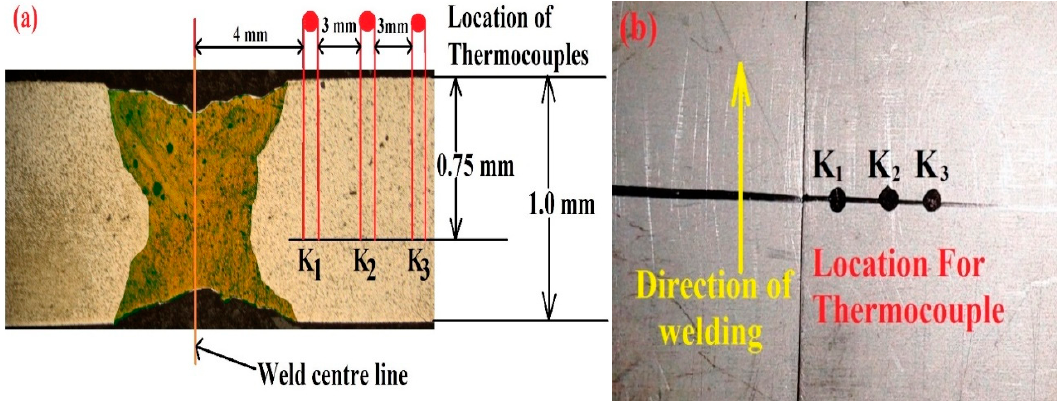
Figure 2. ( a ) Location of the thermocouple from weld center. ( b ) Top view of sample with thermocouple position. Table 3. Constant weld parameters used in present study.